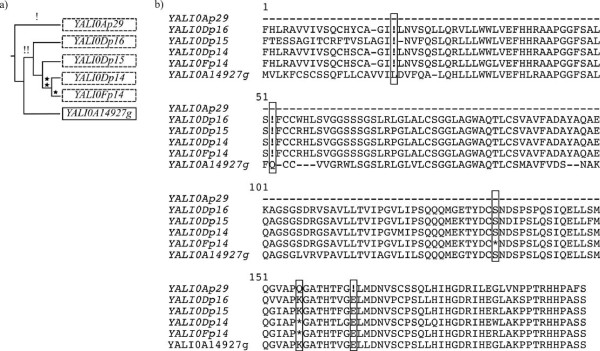
Scenario for the multiplication of pseudogenes in Y. lipolytica. a) Rectangle represents the functional gene, dashed rectangles represent its corresponding pseudogenes. The tree topology is obtained by maximum likelihood reconstruction [69] based on the aligned nucleic acid sequences (branch lengths ignored). The emergence of frameshift mutations (!) and in-frame stop-codons (*) are indicated above corresponding branches. b) Alignment of the translation products of YALI0A14927g and its pseudogenes obtained by MUSCLE. frameshift mutations (!) and in-frame stop-codons (*) are boxed.